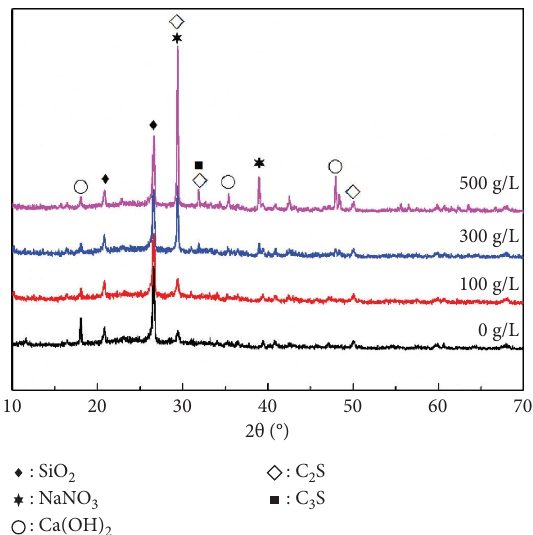
Figure 2: Te XRD patterns of the SFCM with diferent con- centrations of sodium nitrate after curing at 20 ° C for 7